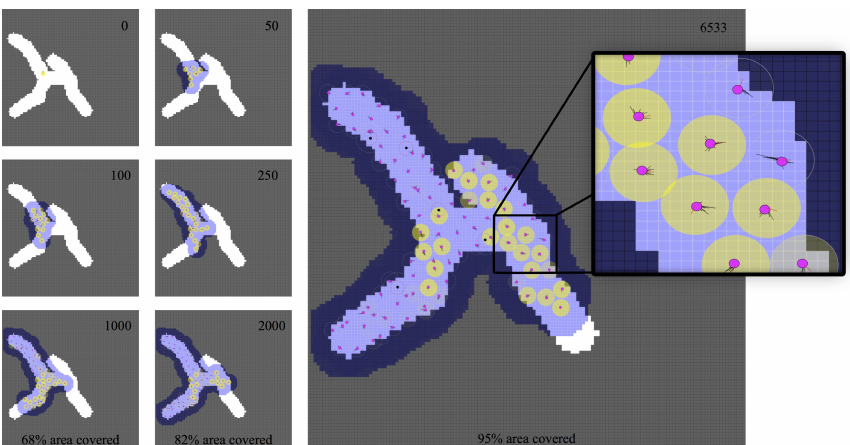
Figure 7. Behavioral trace for different simulation steps. Each simulation step is equivalent to 1/2 s. An enlarged area of the simulation is shown when the target case (95% coverage of the map area) is reached. The figure shows the robots (in red), their communication area RF rmax (yellow), the angles recommended by the beacon robots (black concentric lines around the robot) and their visual or coverage area (blue).